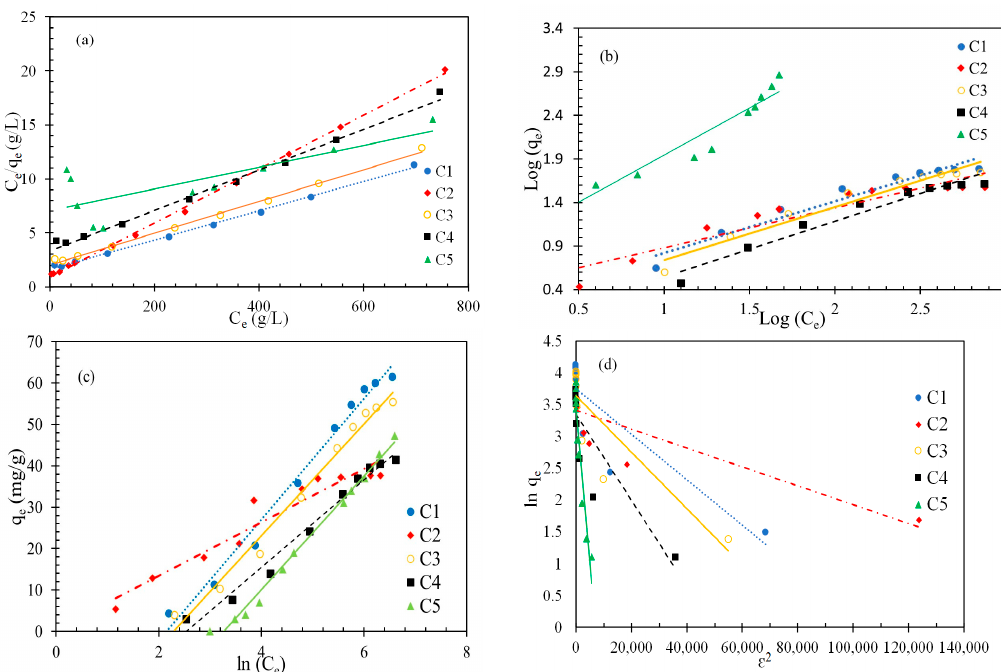
Figure 11. Statistical fitting of data from adsorption isotherms for lead onto di ff erent clays using di ff erent models: ( a ) Langmuir, ( b ) Freundlich, ( c ) Temkin and ( d ) Dubinin–Radushkevich